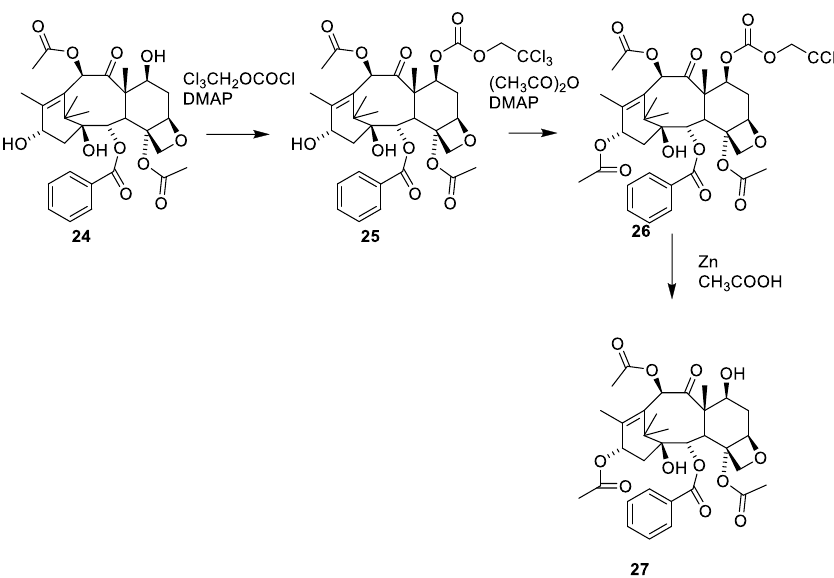
Figure 9. Selective acylation of O-7 and O-13 of taxanes [47]. DMAP is 4-dimethylaminopyridine.